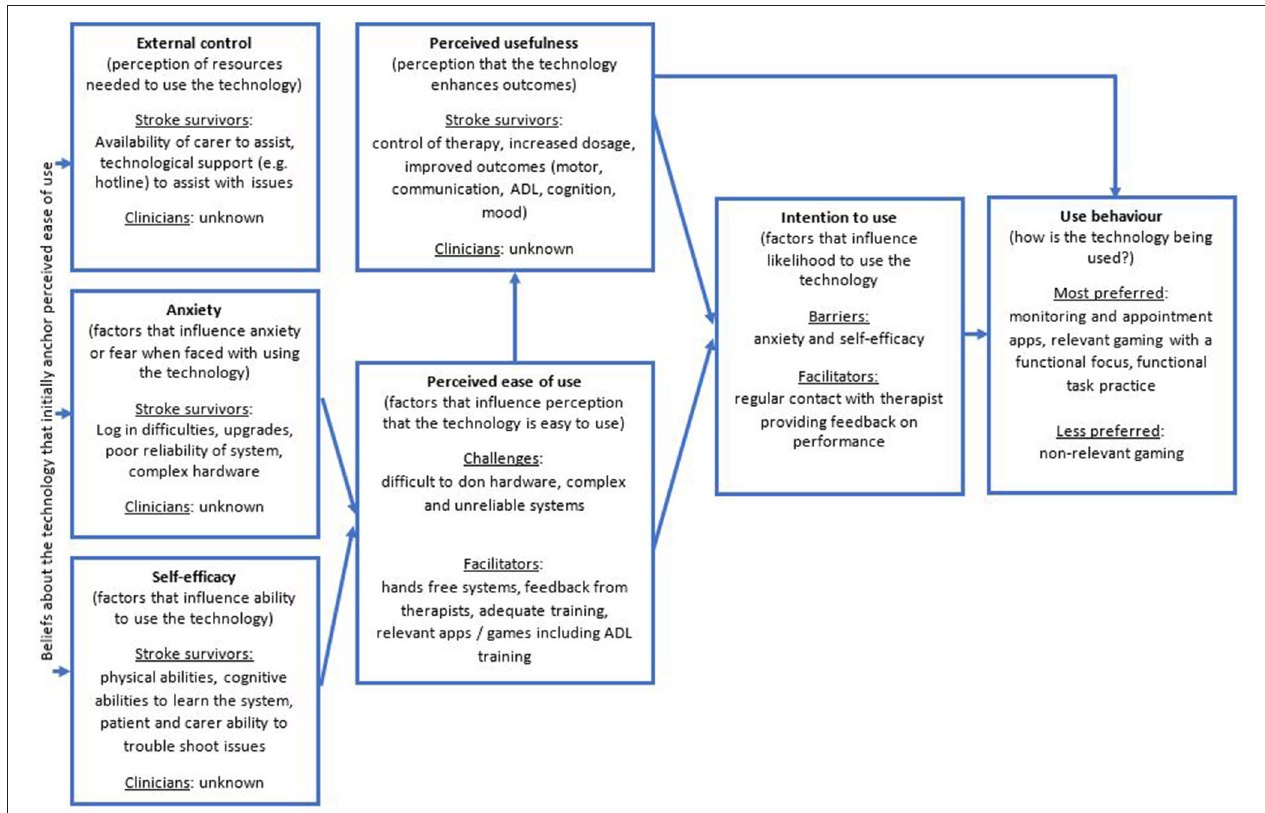
FIGURE 1 | Result of mapping the 22 studies to the variables of the TAM3